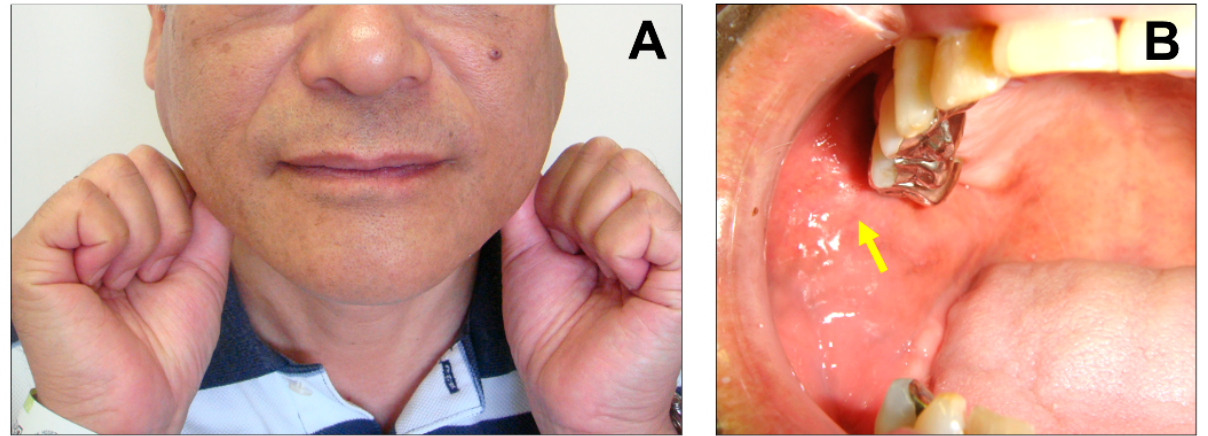
Figure 2. Typical symptoms of pneumoparotid. Crepitus on the parotid region ( A ) and frothy or bubbly saliva from the orifice (yellow arrow) ( B ).